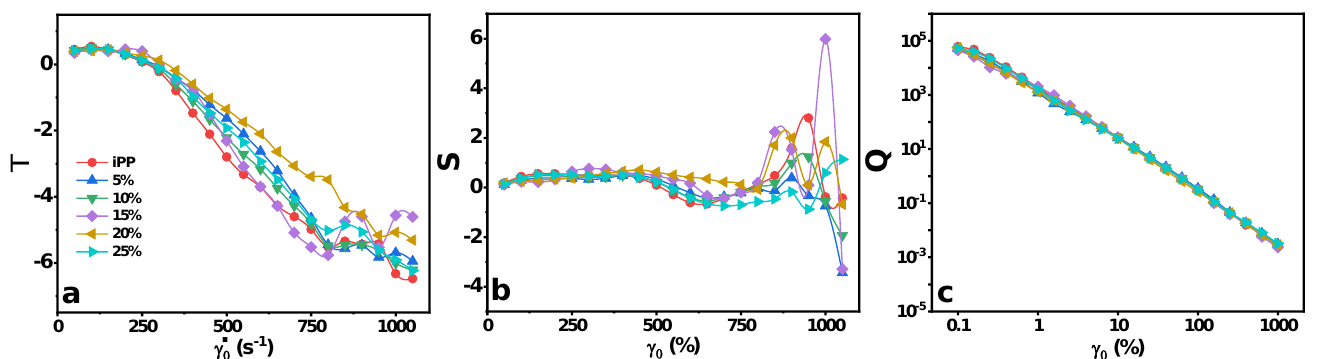
Figure 7. Large-strain elastic modulus ( G L ; a ), minimum-strain elastic modulus ( G M ; b ), large strain-rate dynamic viscosity ( η L ; c ) and minimum strain-rate dynamic viscosity ( η M ; d ) as a func- tion of strain-rate amplitude 𝛾̇ 0 and strain amplitude γ 0 under LAOS stress for pure iPP, LMPP and blends at 1.0 rad s −1